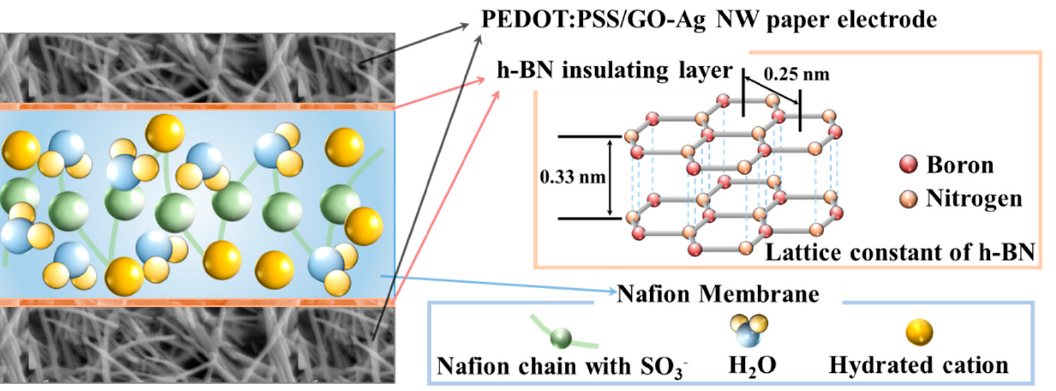
Figure 1. Schematic of ionic electroactive polymer (IEAP) actuator structure with hexagonal boron nitride (h-BN) insulating layers.